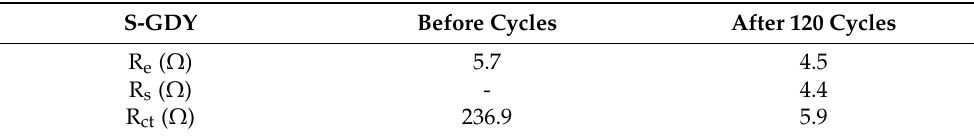
Table 1. Kinetic parameters of the S-GDY electrode before and after 120 cycles at the current density of 0.5 A g − 1 .